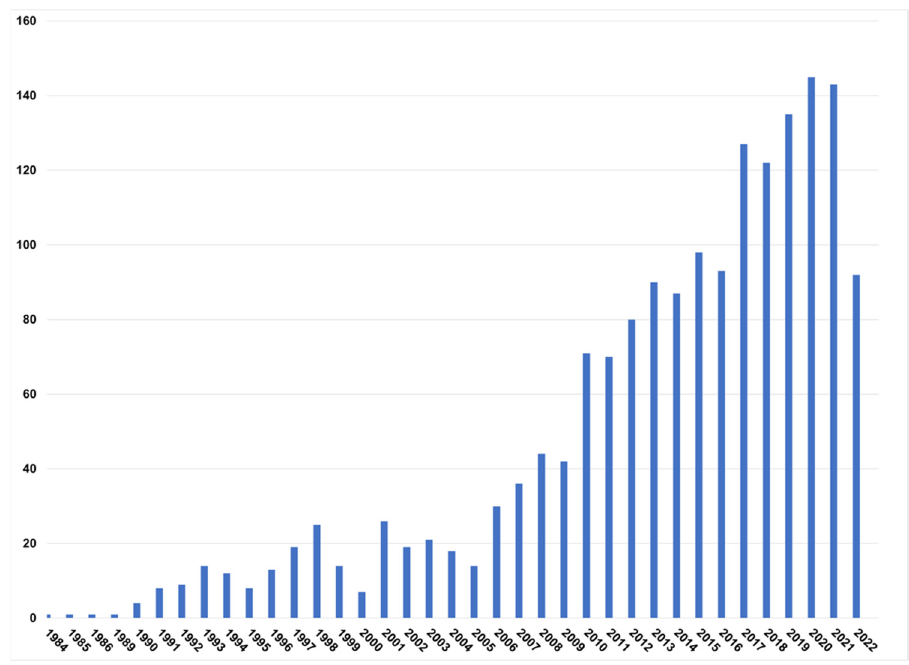
Figure 1. The number of studies published per year using the search string “black liquor gasification OR lignin gasification”, data obtained from the Web of Science.